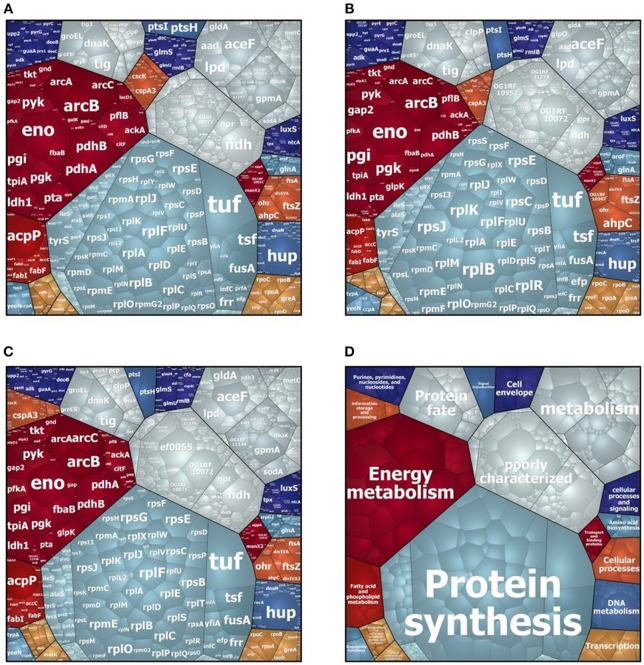
Voronoi treemap visualization of cytosolic proteins of E. faecalis D27 (A), E. faecalis Symbioflor 1 (B) and E. faecalis UW3114 (C). Each protein is represented by a small cell, proteins are clustered according to their functional classification, cell-size correlates with protein abundance. (D) Represents functional organization of proteins.